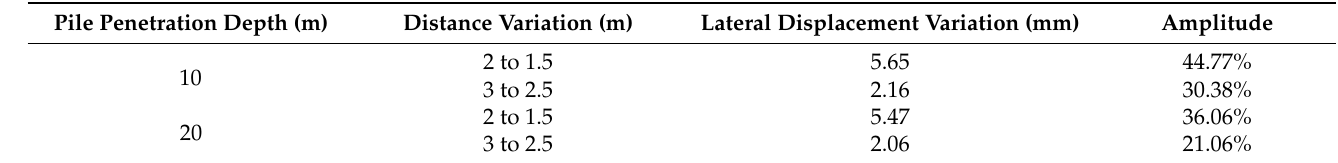
Table 2. Lateral displacement variation due to distance variation between the used and new